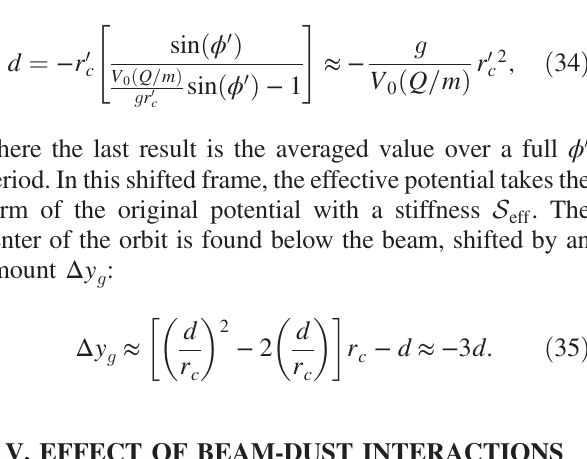
beam screen. On the other hand, if the grain is far from the beam, the charging rate is small and the orbit can last for